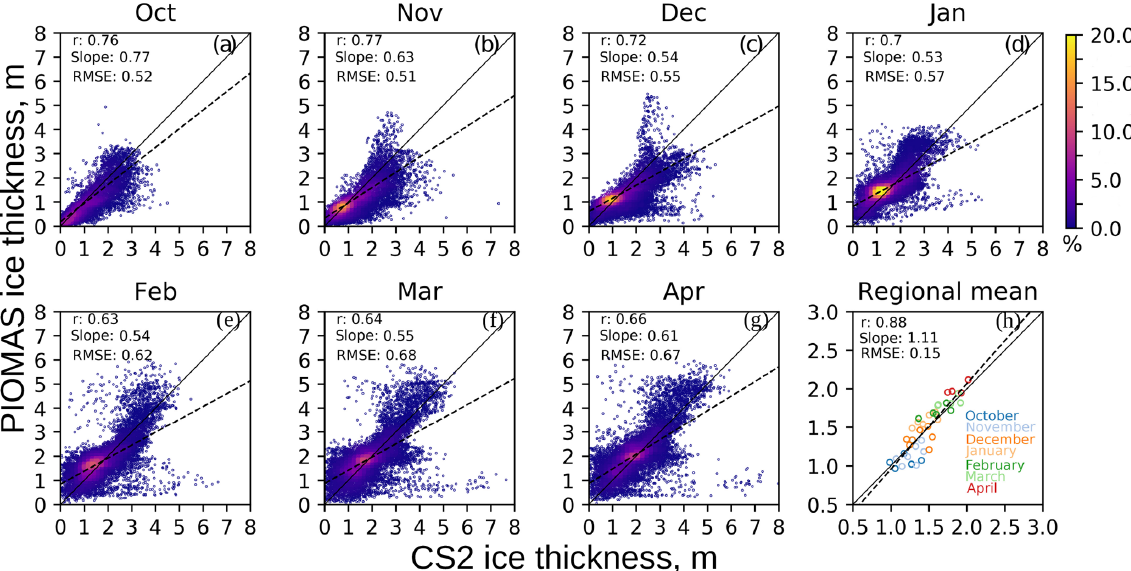
Figure 2. Density scatter plots of PIOMAS and CS2 monthly effective sea ice thickness (m) in the Greenland Sea, October–April 2010– 2016: (a–g) each point corresponds to one grid cell of sea ice thickness. (h) Mean monthly sea ice thickness over the ice-covered area of the Greenland Sea for all intercompared snapshots. The colors of the points in panel (h) correspond to a month. The dashed lines show the linear regression fit and the solid lines are 45 ◦ angles. The correlation coefficients ( r ), the slope of the linear regressions and the root-mean-square error (RMSE) are given in the upper-left